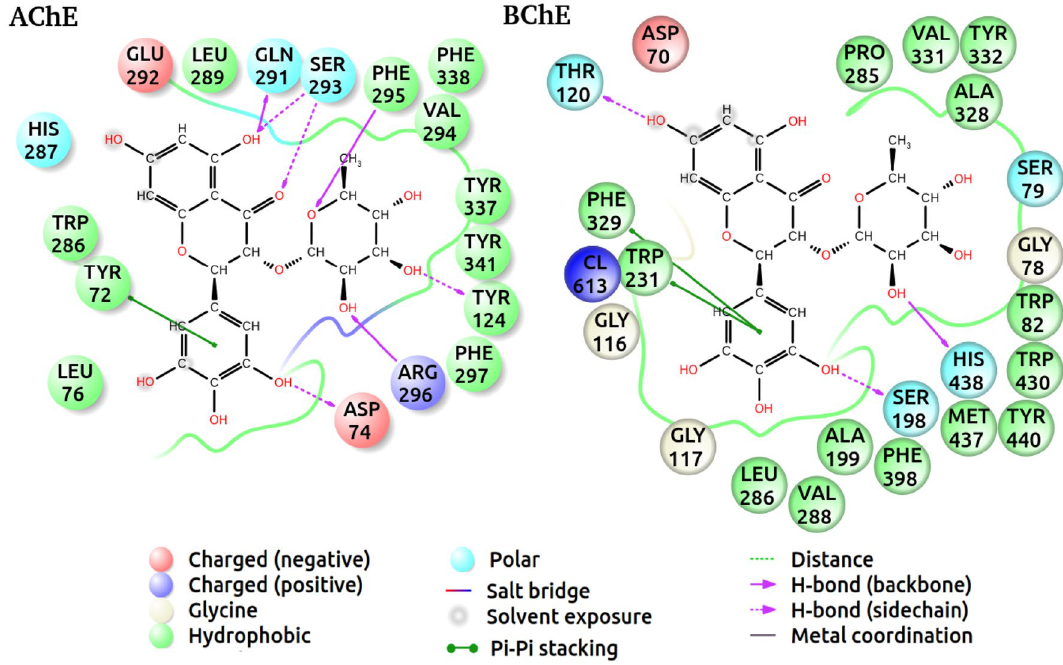
Figure 5. 2D diagrams of compound 1 inside AChE and BChE. The important amino acids surrounding the ligand are presented with different colors, which correspond to their chemical properties. The polar and nonpolar interactions formed between the atoms of the ligand and the amino acids are shown differently (see the legend). The poses were generated from the systems with the lowest binding energies (top scores), which represent the position of the ligand for each complex—however the interactions would vary between the